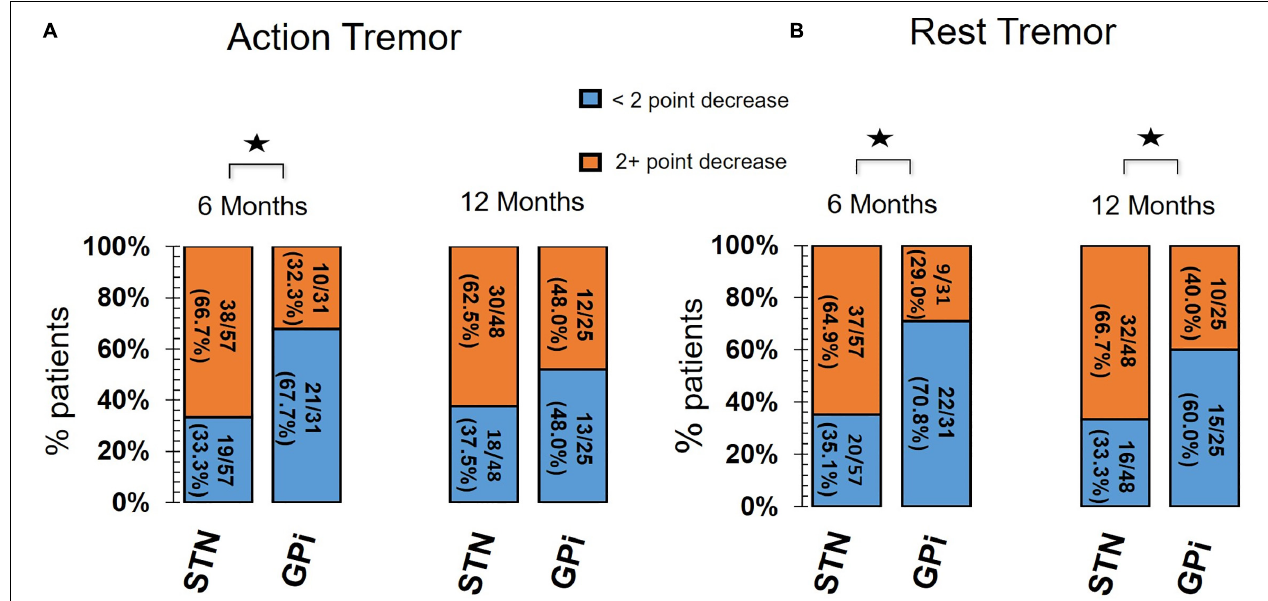
FIGURE 3 | Bar chart for Optimal Responders versus Suboptimal Responders of (A) action tremor and (B) rest tremor. Orange segment of each bar represents number of Optimal Responders with ≥ 2 point drop in tremor score compared to baseline (before surgery). Blue segment of each bar represents number of Suboptimal Responders with < 2 point drop in tremor score compared to baseline. The percentage or proportion of patients who were either optimal or suboptimal responders to STN DBS and GPi DBS for action tremor and rest tremor are shown at 6 and 12 months follow-up. UPDRS part III item 20 (for arm contralateral to DBS) was used for assessment of rest tremor. UPDRS part III item 21 (for arm contralateral to DBS) was used for assessment of action tremor. The STN DBS group had significantly greater number of optimal responders compared to suboptimal responders in the GPi DBS group for action tremor at 6 months and rest tremor at 6 and 12 months. *Denotes a statistically significant difference between STN and GPi groups.